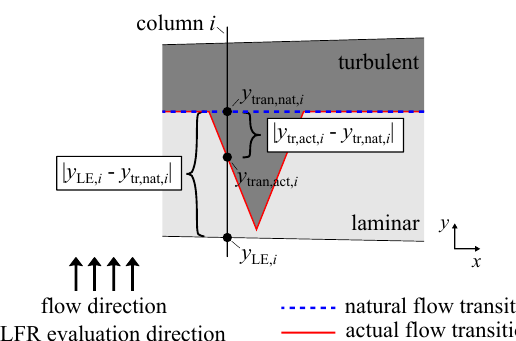
Figure 4. Sketch of the parameter used for calculating the relative length LFR i of premature turbulent flow in column i normalized to the distance of laminar flow if no premature flow transition would occur: the distance between leading edge y LE, i and natural flow transition y tr,nat, i . The laminar flow reduction (LFR) is a figure of merit for the reduction of the laminar flow regime surface area due to premature flow transitions triggered by surface defects.